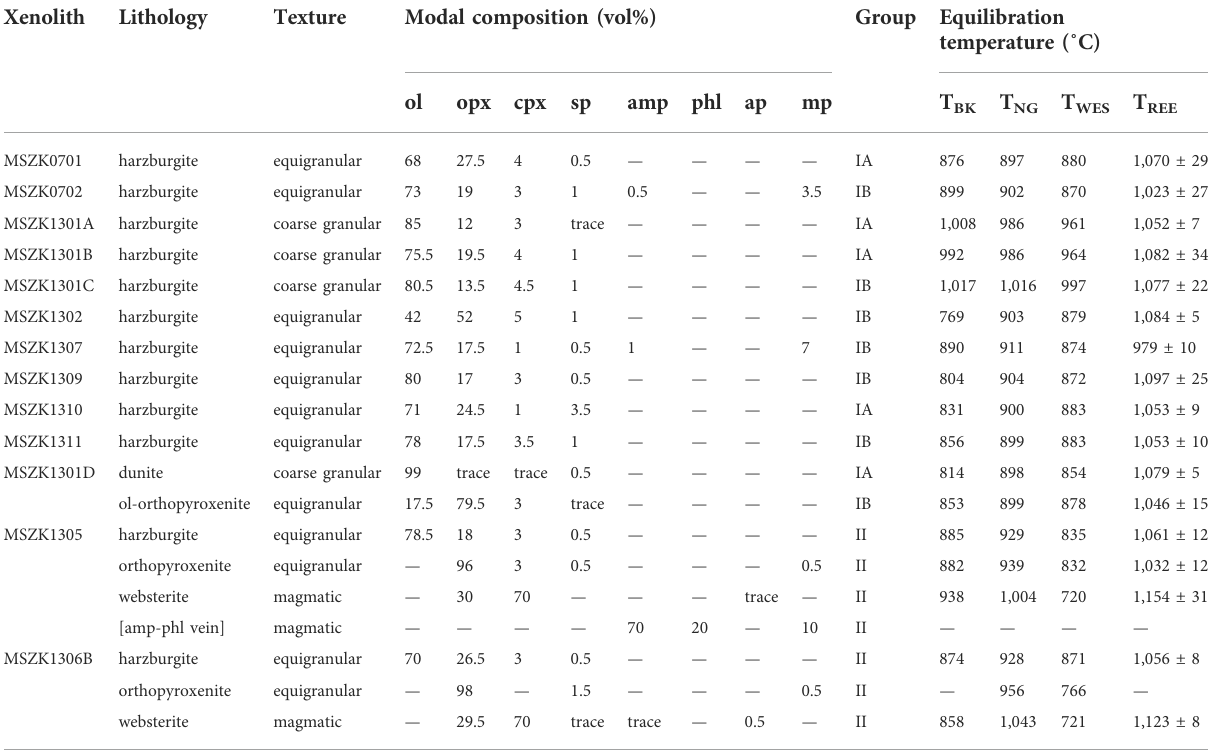
TABLE 1 Petrographic properties and calculated equilibration temperatures of the studied xenoliths. Equilibration temperatures were calculated usingthermometersasfollows:T BK ,two-pyroxenemethodofBreyandKöhler(1990);T NG ,Ca-in-opxmethodofBreyandKöhler(1990)modi fi edby Nimis and Grütter (2010); T WES , Al and Cr in opx method of Witt-Eickschen and Seck (1991); T REE , REE method of Liang et al. (2013).